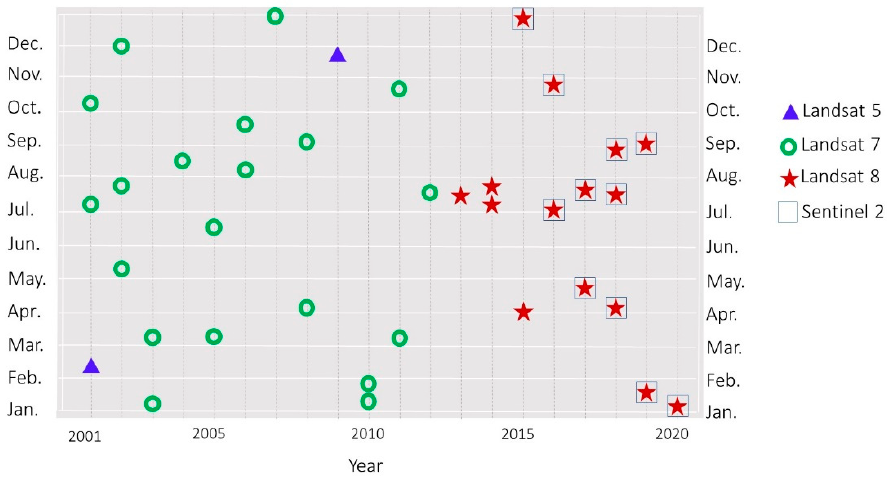
Figure 2. Temporal distribution of Landsat and Sentinel 2.